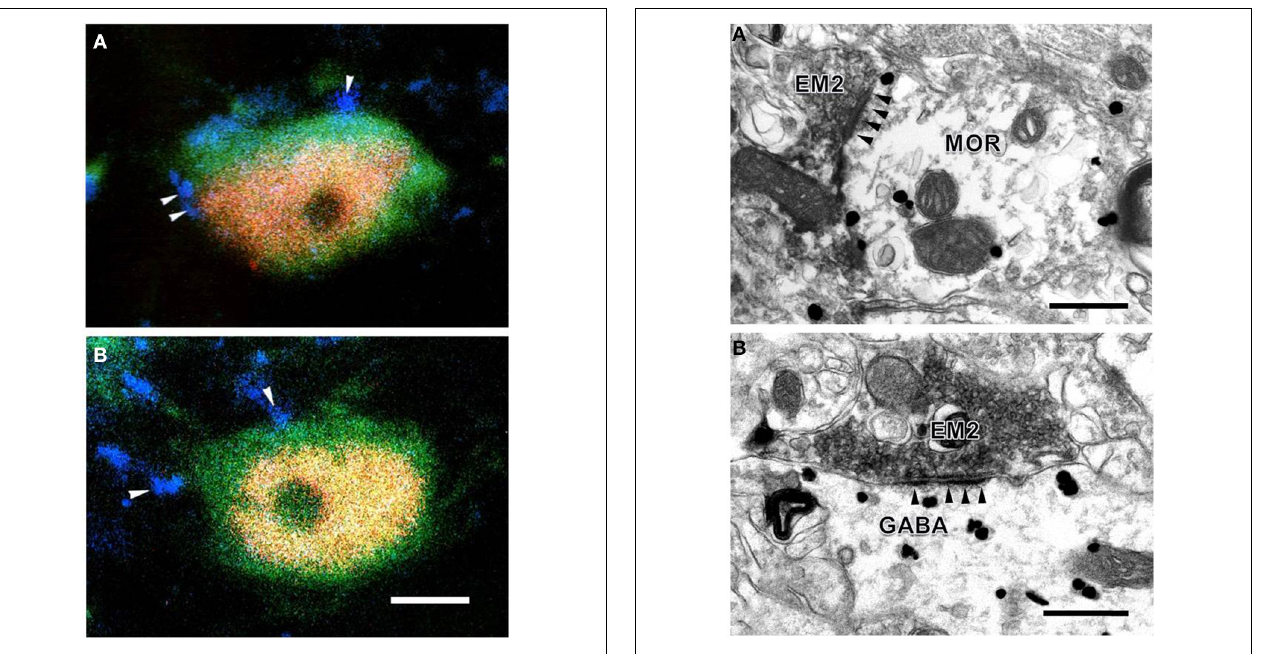
FIGURE 3 | The fluorescence photomicrographic images of triple-labeling showing the connections between EM2-IR terminals and GABA/FOS or MOR/FOS double-labeled neurons in lamina II of the Vc ipsilateral to the formalin injecting into the lower lip of the mouth. Some of the EM2-IR terminals ( A , B ; blue, arrowheads) were in close contacts with GABA (green) and FOS (red) double-labeled neurons (A) and with MOR (green) and FOS (red) double-labeled neurons (B) . Scale bar = 8 μ m.